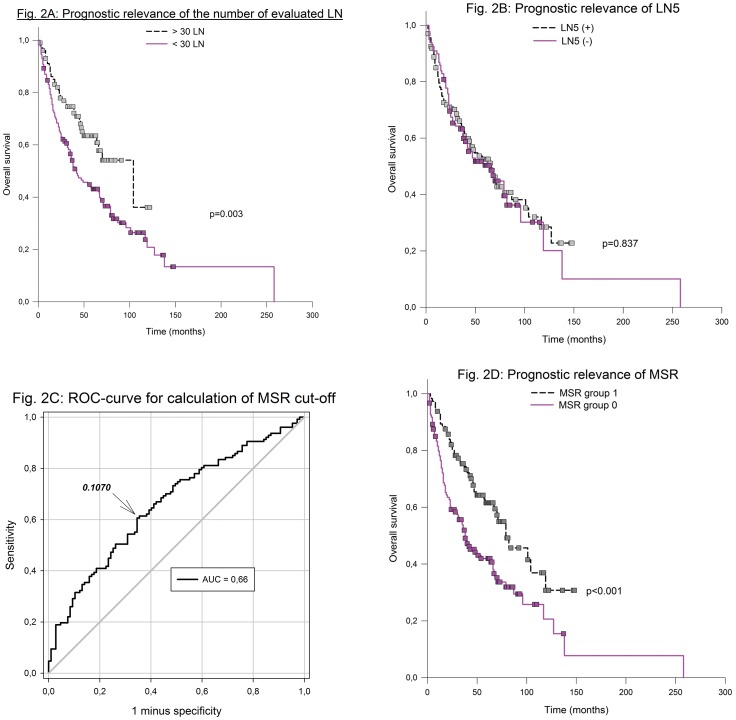
Prognostic relevance of the number of evaluated lymph nodes (A); prognostic relevance of LN5 alone (B); ROC curve for calculation of MSR cut-off (C); prognostic relevance of MSR (D).